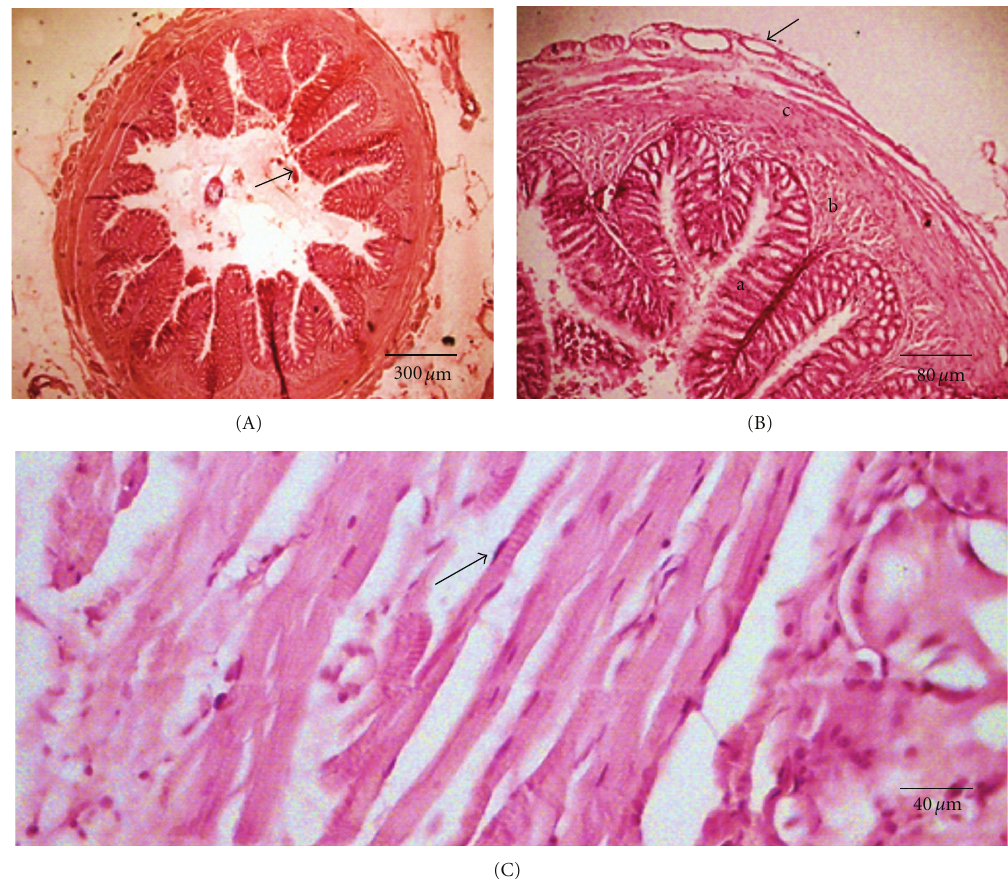
Figure 4: Cardiac stomach of S. fuscus . (A) Primary esophagic folds with cardiac mucosa (arrow); (B) gastric glands in stomach lamina pro- pria: (a) conjunctive tissue which forms the submucosa (b), muscular layer (c), and arrow indicating serosa; (C) muscular layer with arrow indicating striated skeletal muscle